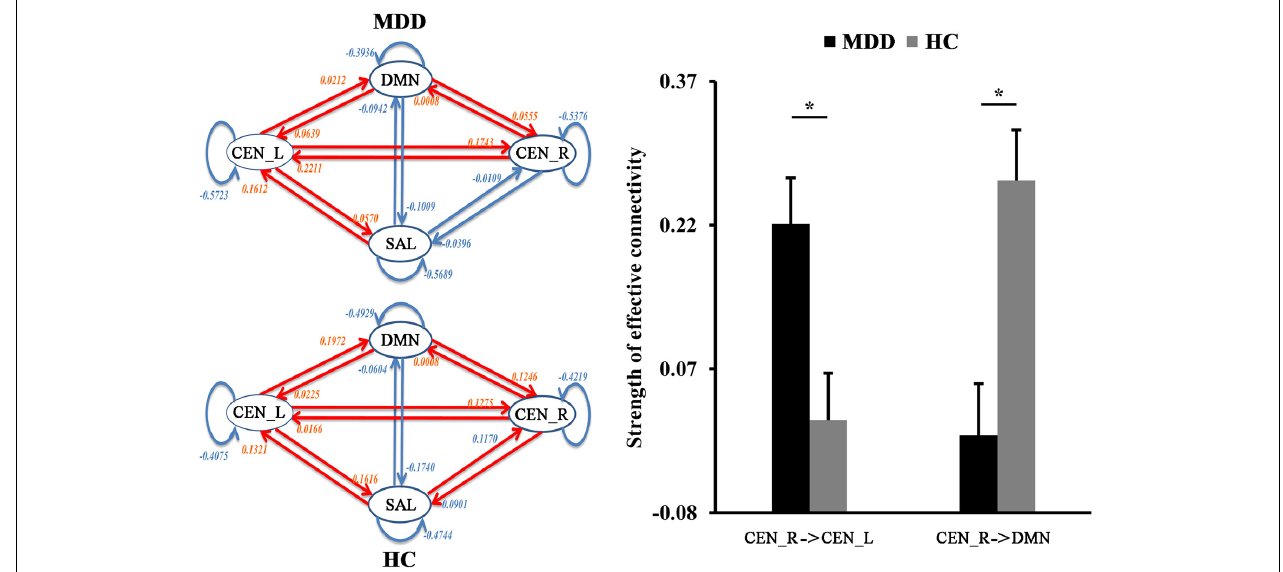
FIGURE 3 | The differences in functional network effective connectivities. Dynamic causal modeling was used to determine the differences in effective connectivities between the triple networks. The significantly increased effective connectivity from right to the left central executive network (CEN) was found in MDD patients while significantly decreased effective connectivity from right CEN to default mode network (DMN) was found in MDD patients. *Represents significant